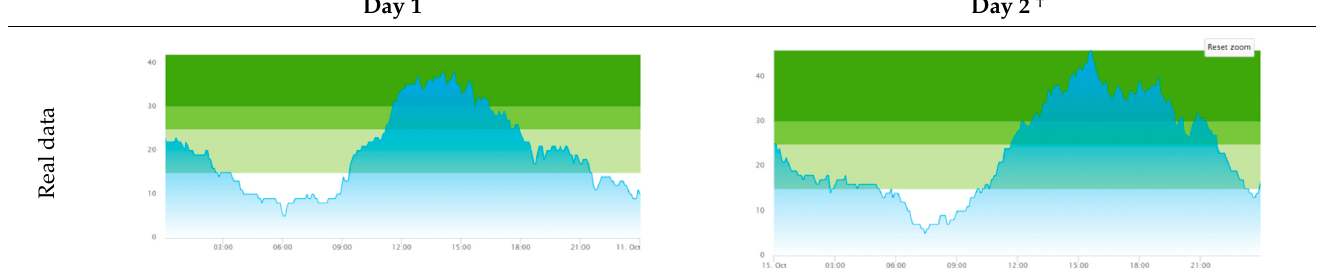
Table 3. Showing the patient crowding for the two representative days in a pre-pandemic setting. Day 1